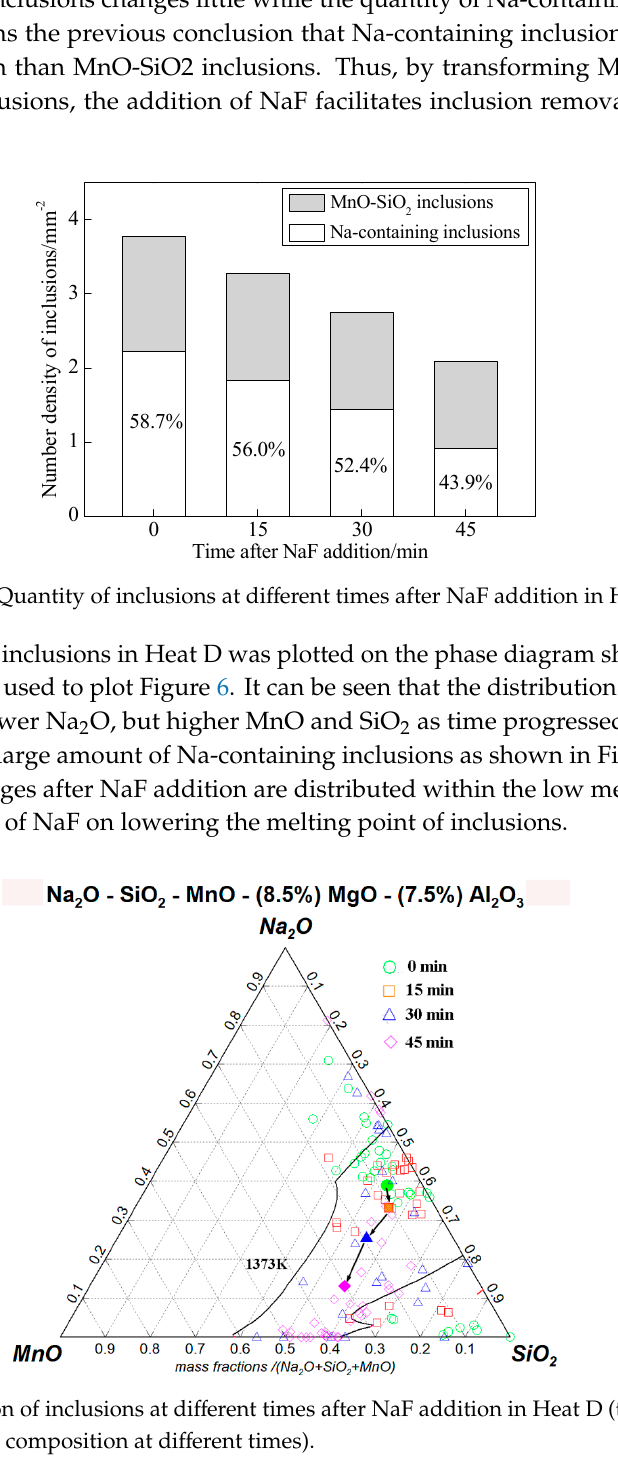
Quadratic fitting curve of SiO Quadratic fitting curve of MnO y=28.6-1.09x+0.012x 2